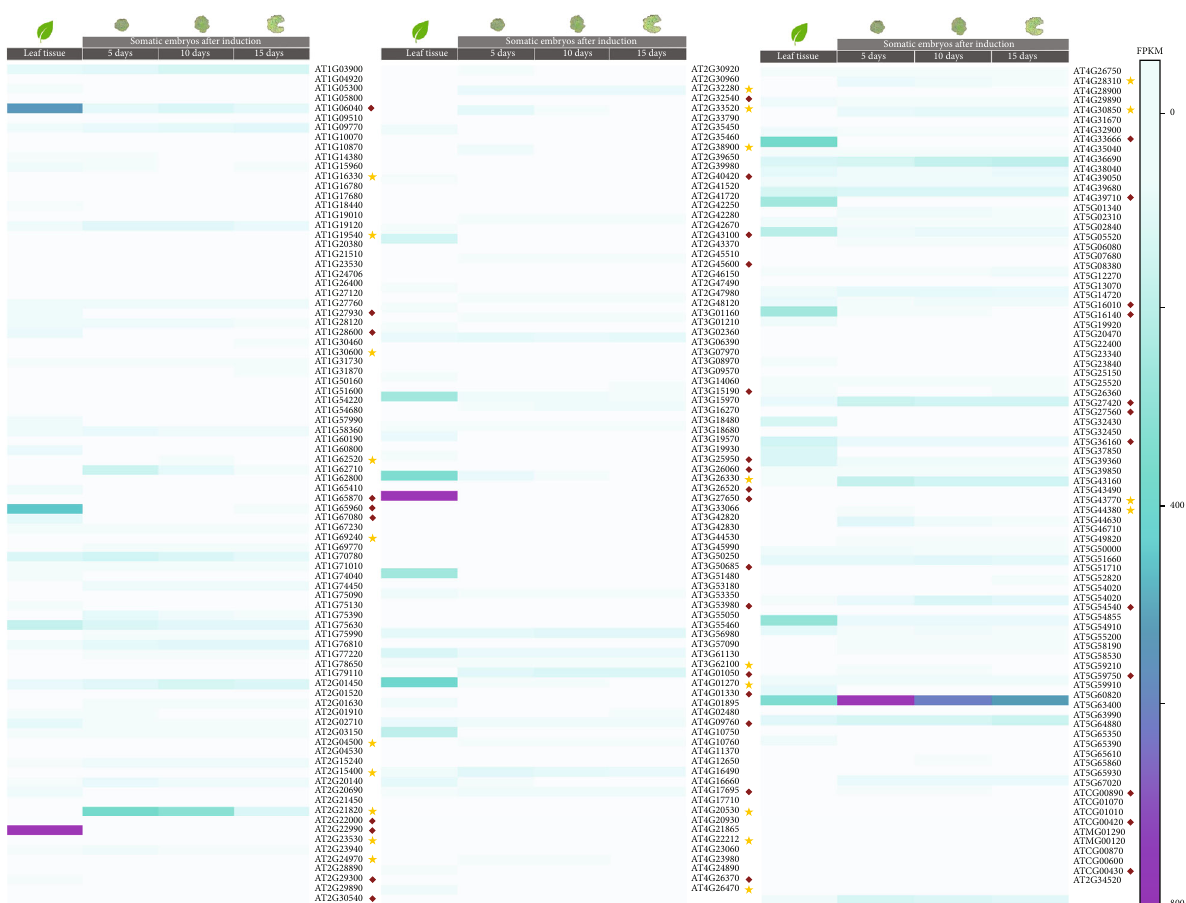
Figure 7: Transcript abundance extracted from the somatic embryo transcriptome dataset, E-MTAB-2465 for the hub genes. The hub genes FC ≥ 2 : 0 ) and downregulated ( log FC ≤ − 2 : 0 ) in somatic embryonic tissues compared to leaf tissues are signi fi cantly upregulated ( log 2 2 indicated with yellow asterisks and red diamonds, respectively. Transcript abundances are shown in fragments per kilobase of transcript per million mapped reads